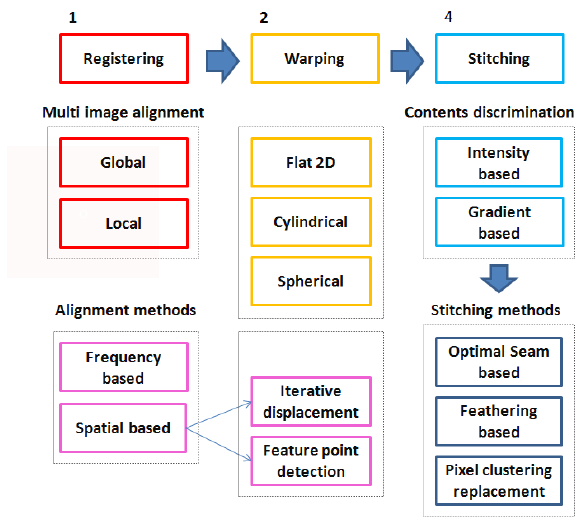
Figure 1. Mosaicing